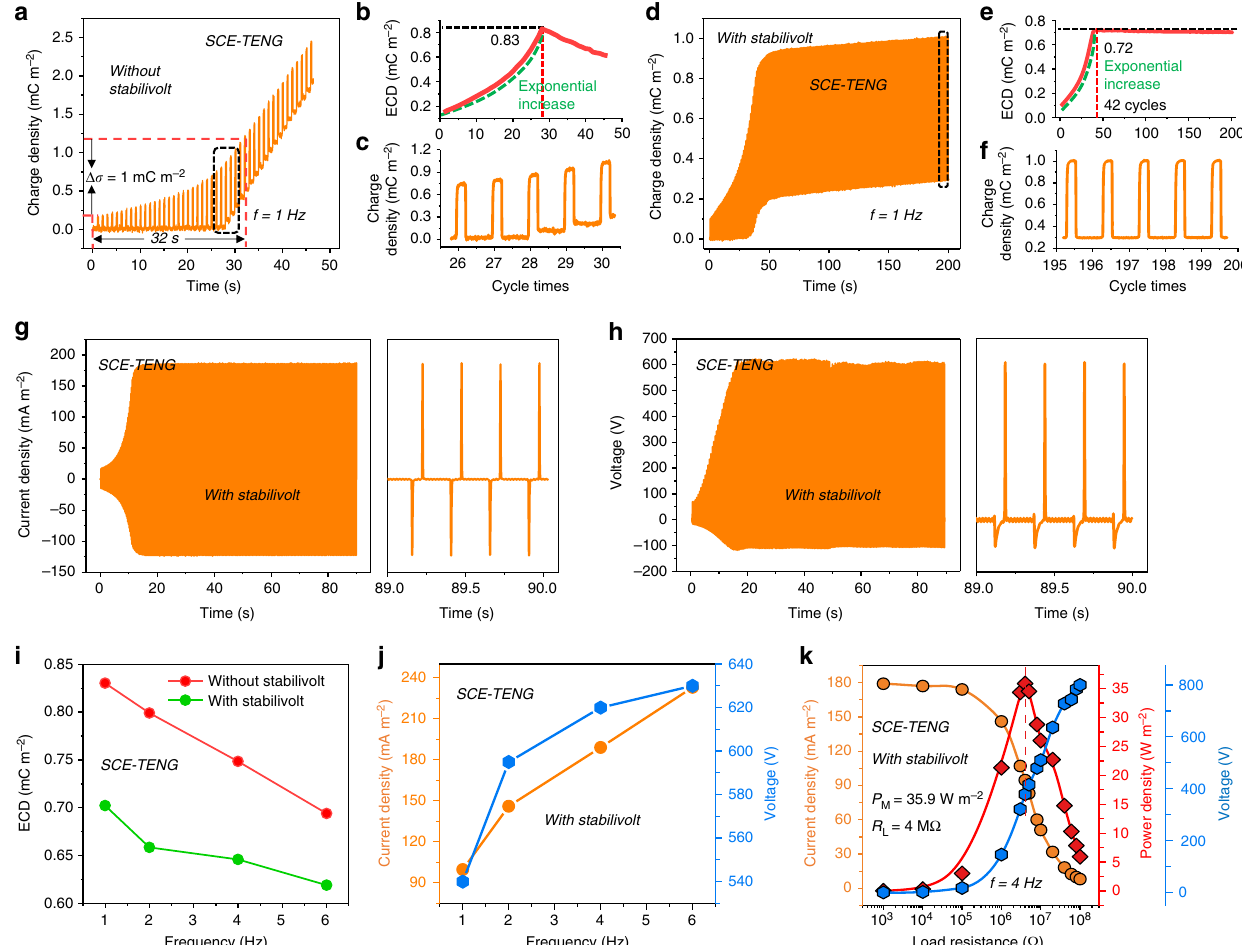
Fig. 4 Output performance of self-charge excitation triboelectric nanogenerator. a The dynamic output charge process of SCE-TENG without voltage stabilization element under 1 Hz operation frequency. b The ECD versus operation cycles. c The detailed output charge curve from the dashed area. d The dynamic output charge accumulation process of SCE-TENG with voltage stabilization element under 1 Hz operation frequency. e The ECD versus operation cycles. f The detailed output charge curve from the dashed area. g , h Dynamic current and voltage output of SCE-TENG with voltage stabilization under 4 Hz operation frequency, respectively, and the right side of each is the enlarged saturated output curve. i ECD of SCE-TENG under various operation frequencies with/without voltage stabilization. j Current and voltage output of SCE-TENG under various operation frequencies with voltage stabilization. k The current, voltage and power output of SCE-TENG with voltage stabilization under various external load (sinusoidal motion with 4 Hz frequency).